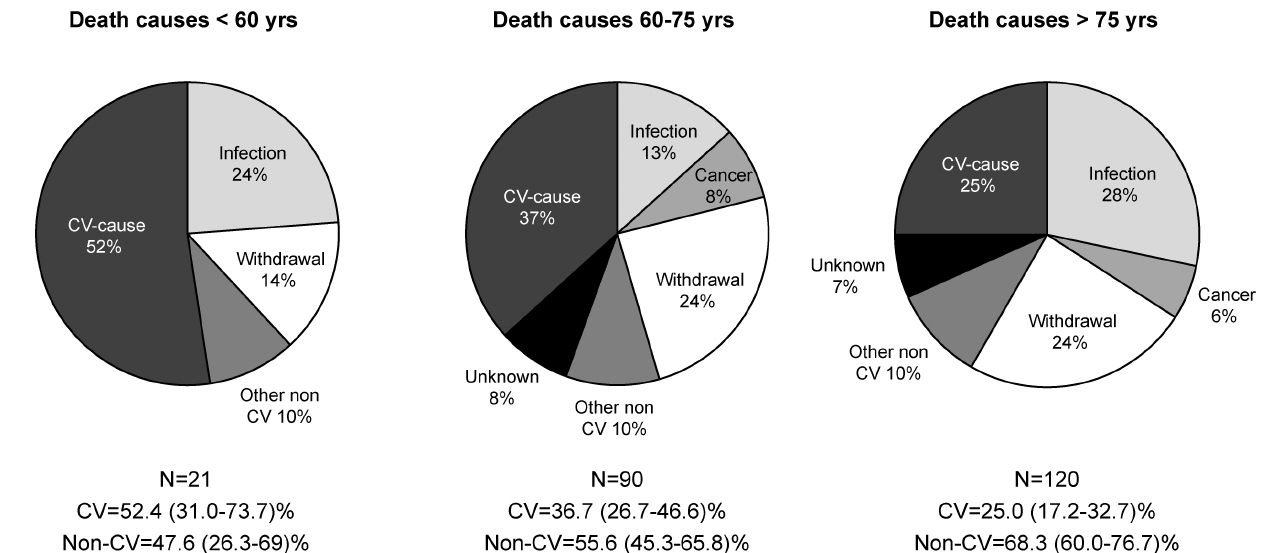
Figure 1. The distribution of death causes across age groups at time of death.